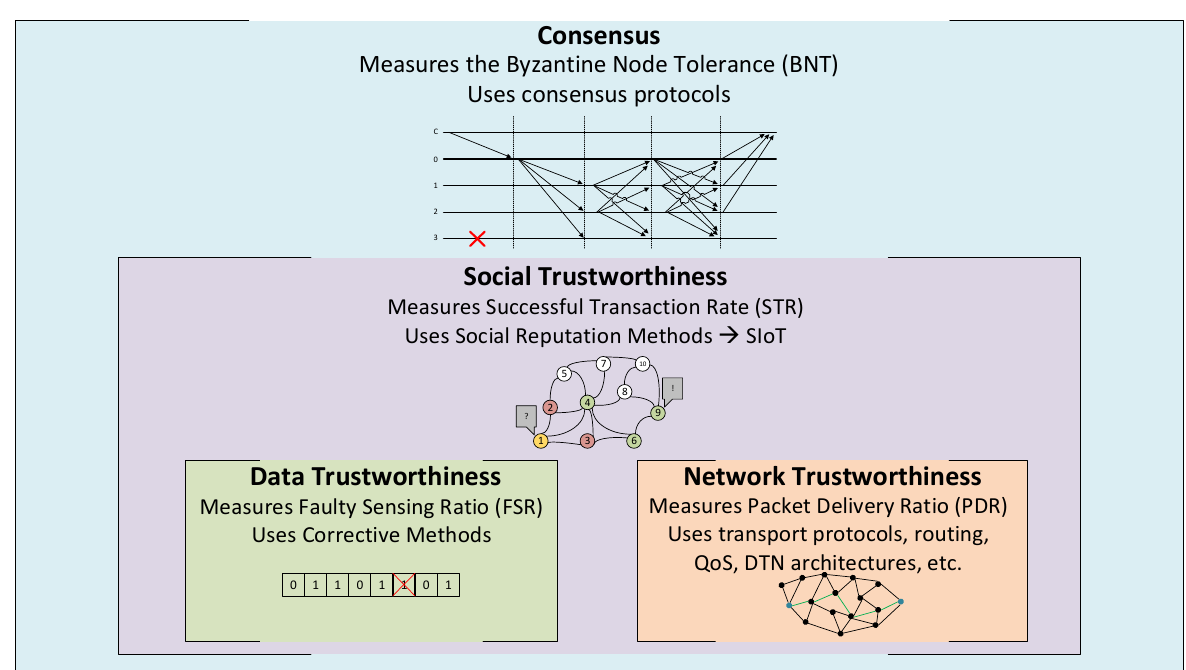
Figure 2. Layers of the proposed trustworthiness model.